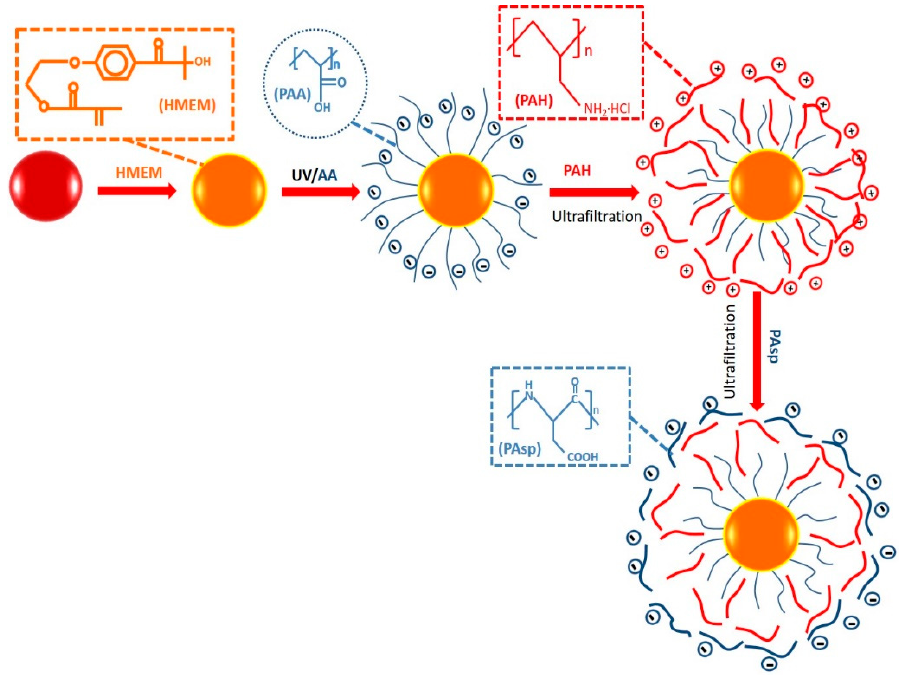
Figure 1. Schematic illustration of the modification of SPBs by layer-by-layer self-assembly.